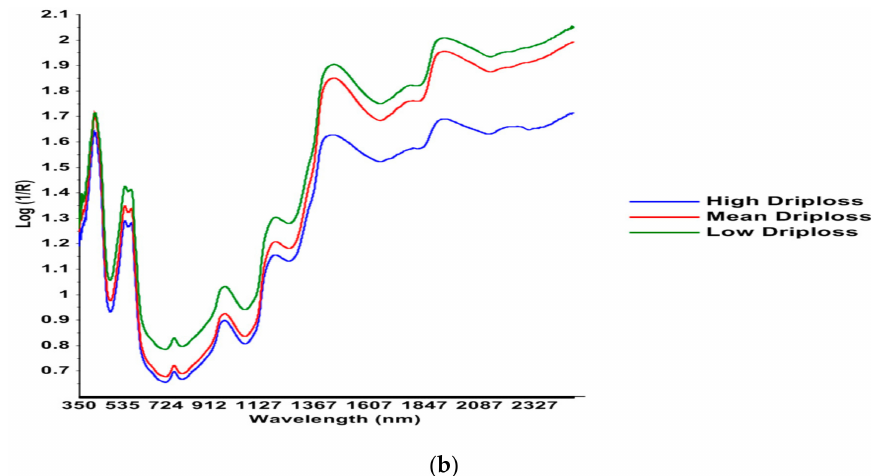
Figure 2. Average Vis–NIR spectra recorded from the LTL muscle (48 post-mortem). ( a ), Spectra of 10 high-ultimate-pH and 10 low-ultimate-pH carcass samples, ( b ) spectra of 10 high-drip-loss and 10 low-drip-loss carcass samples compared to the average spectrum of all samples.